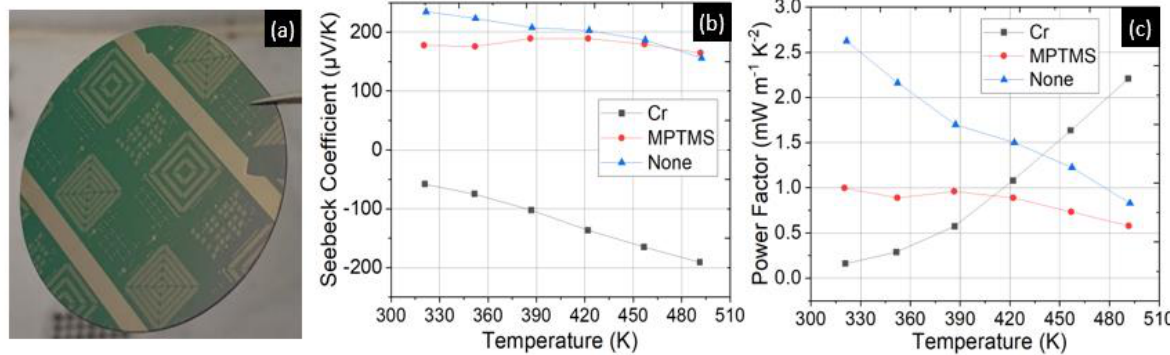
Figure 10. ( a ) Successful lift-off on a Si/SiO 2 substrate after deposition of p − type thin films. ( b , c ) Comparison of thermoelectric data measured on Si/SiO 2 substrates from runs 1r, 1s, and 1t from Table 3 with the adhesion layers as stated in the legend. Application of MPTMS resolved the negative Seebeck data issue while facilitating lift-off of p-type thin films. Table 4. Comparison of this work with other studies on near room temperature deposition of Bismuth Telluride thin films using evaporation and sputtering based